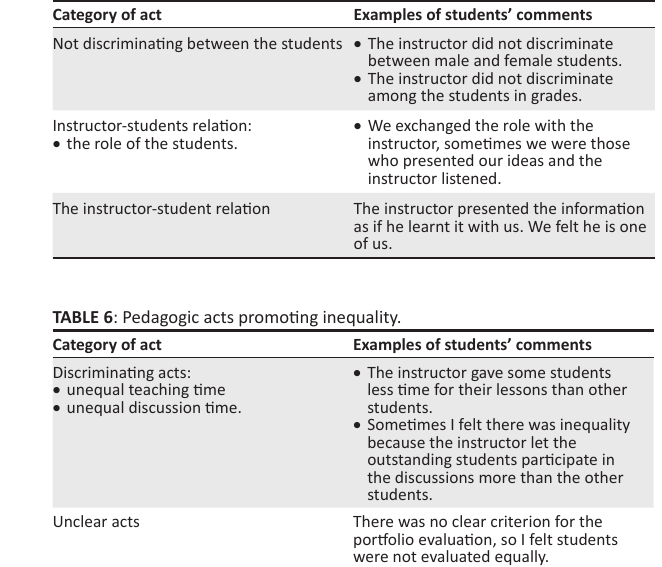
TABLE 5 : Pedagogic acts promoting equality.